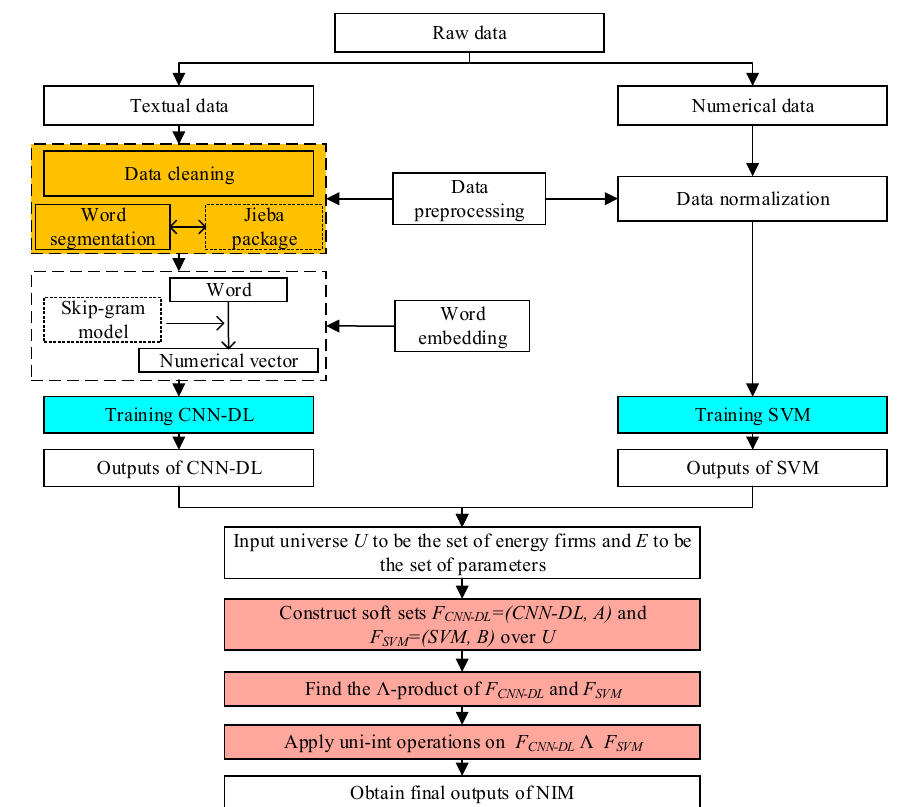
Figure 2. The algorithm of NIM for corporate failure forecasting in the Chinese energy sector.